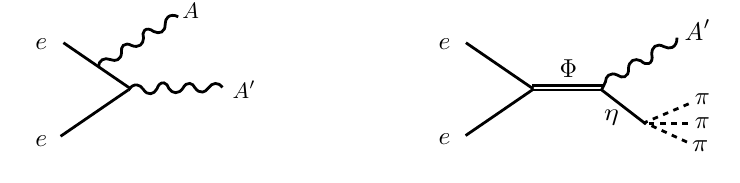
Figure 7 . Diagrams for the di(cid:11)erent production mechanisms of hidden photons at e + e radiative return (left) and meson decays